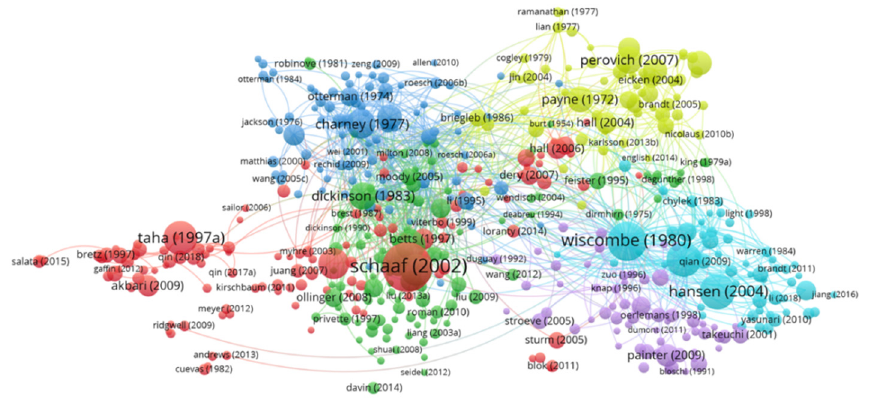
Figure 4. Citation connections for highly cited papers. Colours indicate different clusters with similar research subjects, and sizes vary with citation frequency.